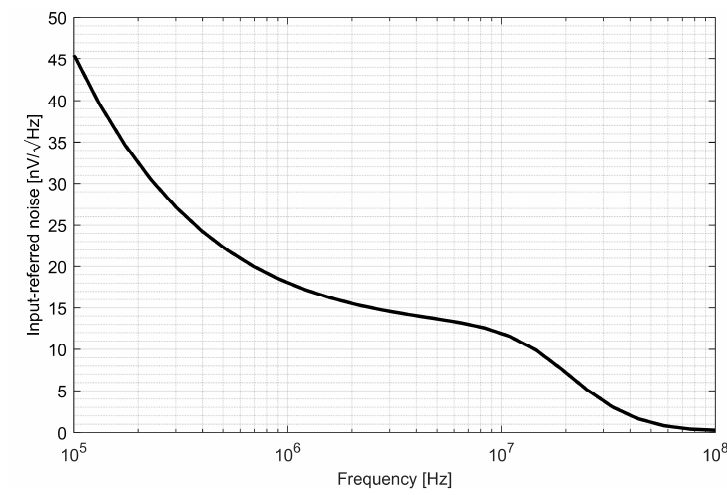
Figure 18. Intermediate frequency noise characteristics.